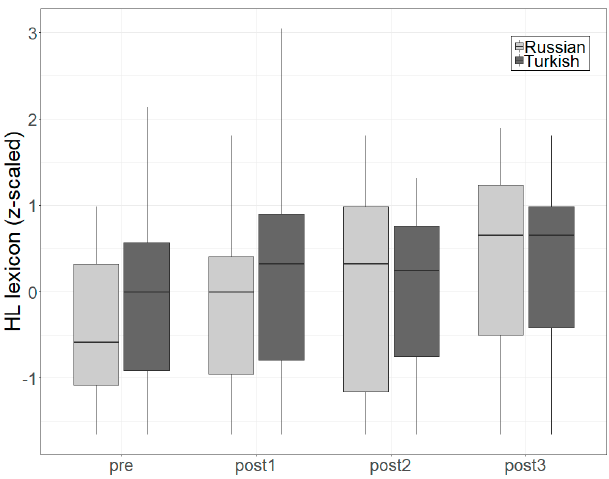
Figure 1. Development of the HL lexicon of Russian (light) and Turkish (dark) heritage speakers. Bars represent quartiles above and below the median (middle line), whiskers represent the extreme quartiles.